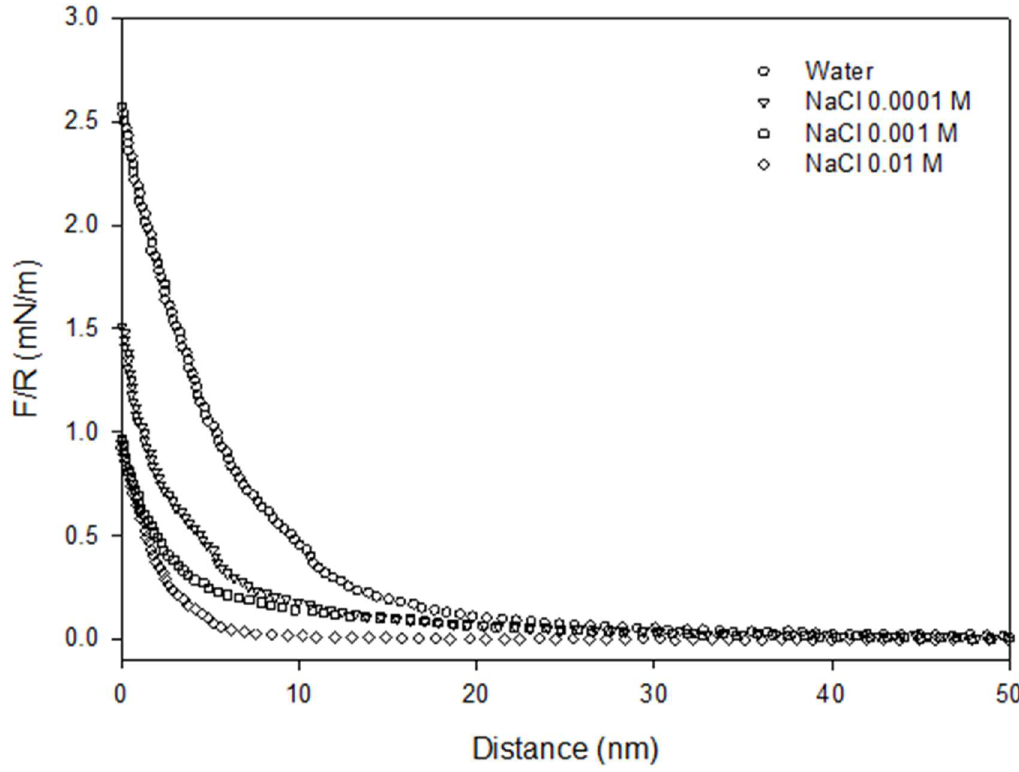
Fig 4. Effect of the electrolyte concentration on the interaction between BSA and PEO.